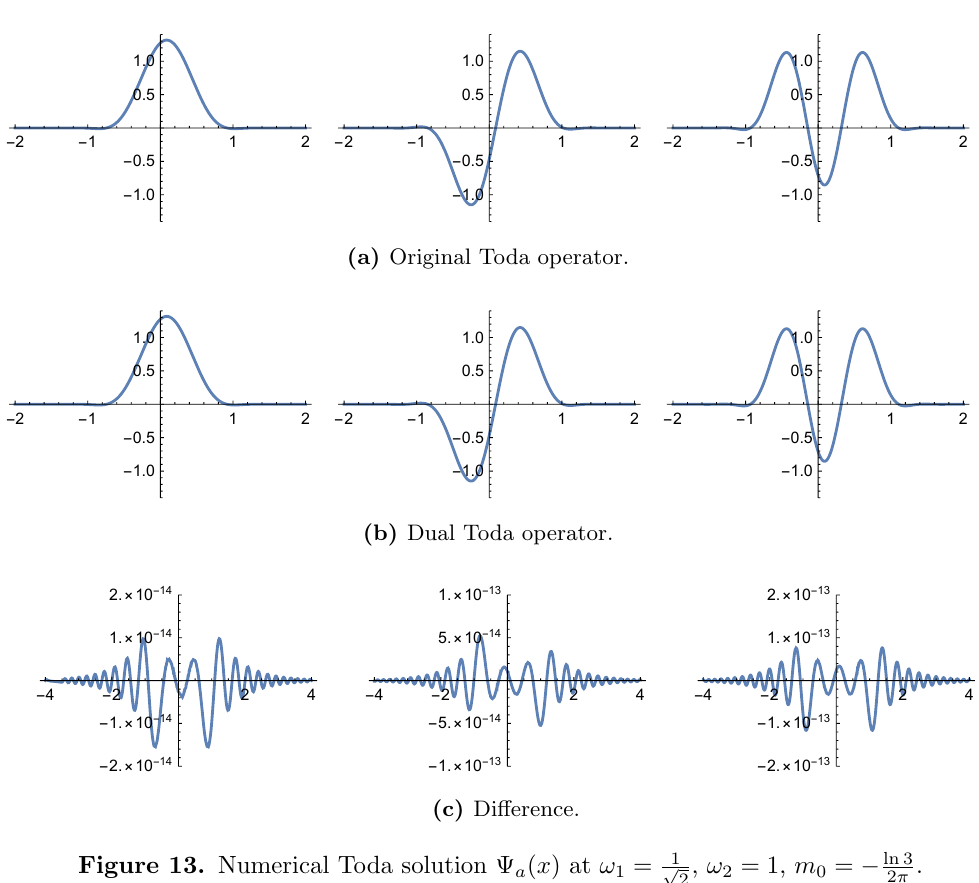
Figure 13. Numerical Toda solution (cid:9) a ( x ) at ! 1 = 1 p